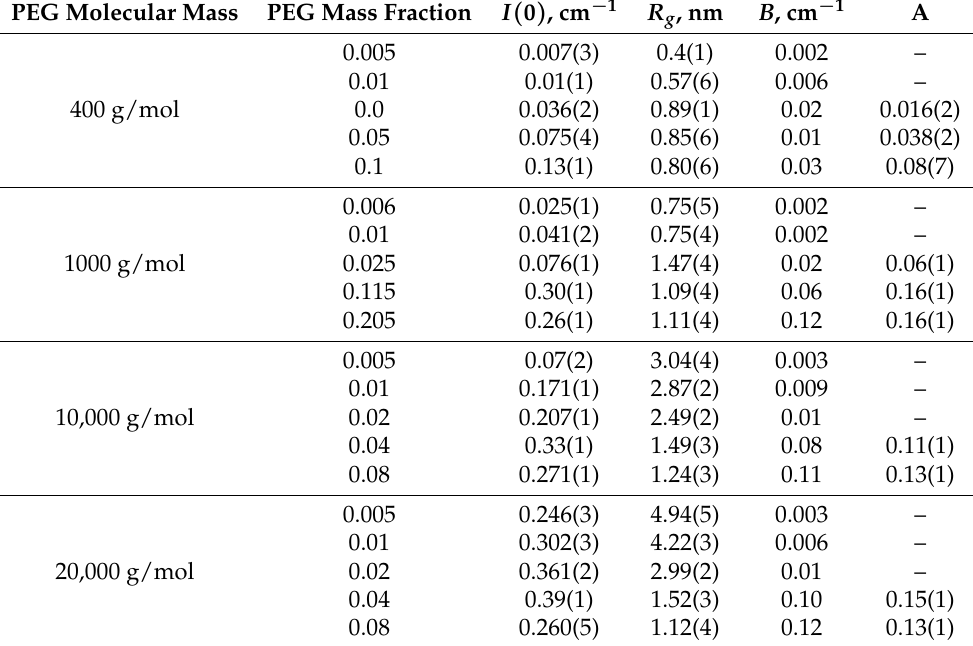
Table 1. Parameters of Equations (1) and (2) obtained by fitting to SANS data of aqueous PEG